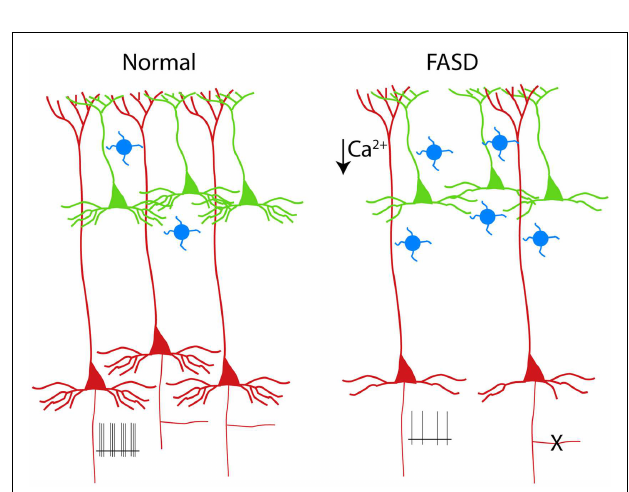
FIGURE 2 | Schematic drawing of PNs in a normal cortical column (left) .The alterations of PNs observed in experimental models of FASD are shown on the right (3–6). Supragranular and infragranular PNs are shown in green and red, respectively. Note the reduced population of L5 PNs (or the pruning of their axon collateral, X ) and the simplification of the basal (but not apical) dendrites.The hypoexcitability of L5 PNs (shown as reduced number of spikes at the axon level) is a consequence of reduced dendritic calcium spikes (5).The increased number of calretinin interneurons (blue cells) is also shown